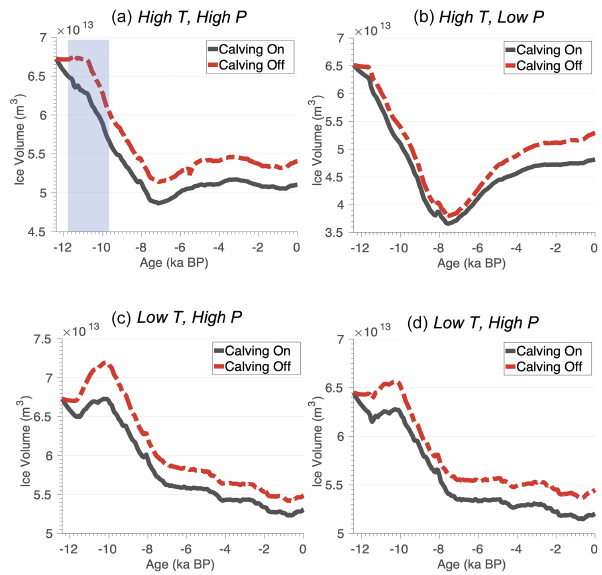
Figure 7. Holocene ice volume ( × 10 13 m 3 ) evolution for each model experiment. Refer to Table 1 for a summary of the climate forcings used in each experiment. Black lines denote those simula- tions with the calving parametrization turned on. Dashed red lines denote those simulations with the calving parametrization turned off. The vertical blue bar above marks a time period (12–10ka) used for analysis presented in Figs. 8 and 9.